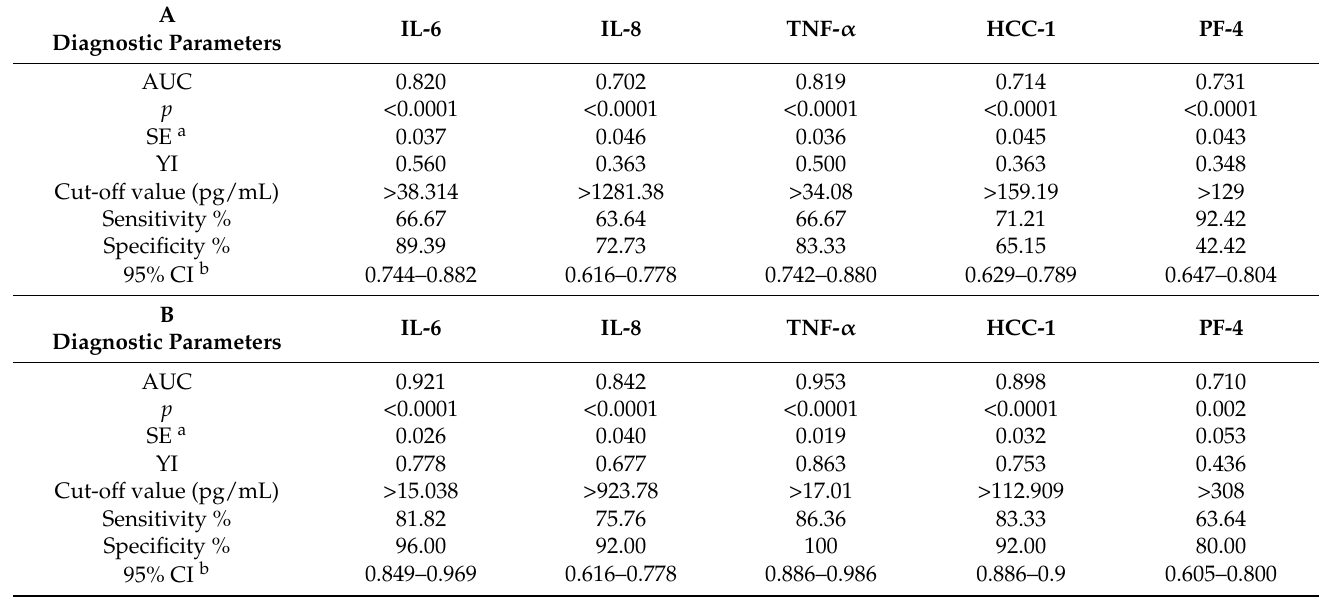
Table 3. Diagnostic utility of salivary cytokines to distinguish ( A ) OSCC from OL patients and ( B ) OSCC from control